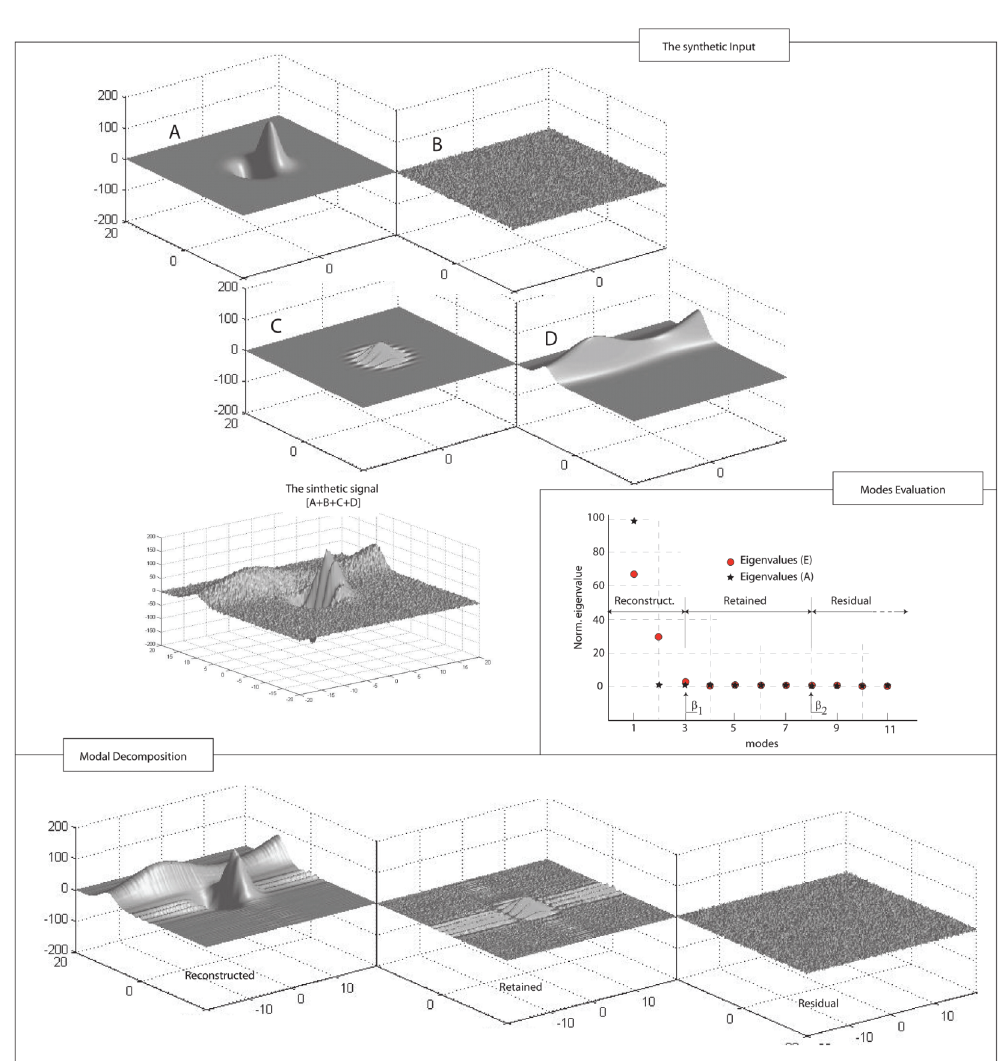
Fig. 1. Test of the modal decomposition with a synthetic model as